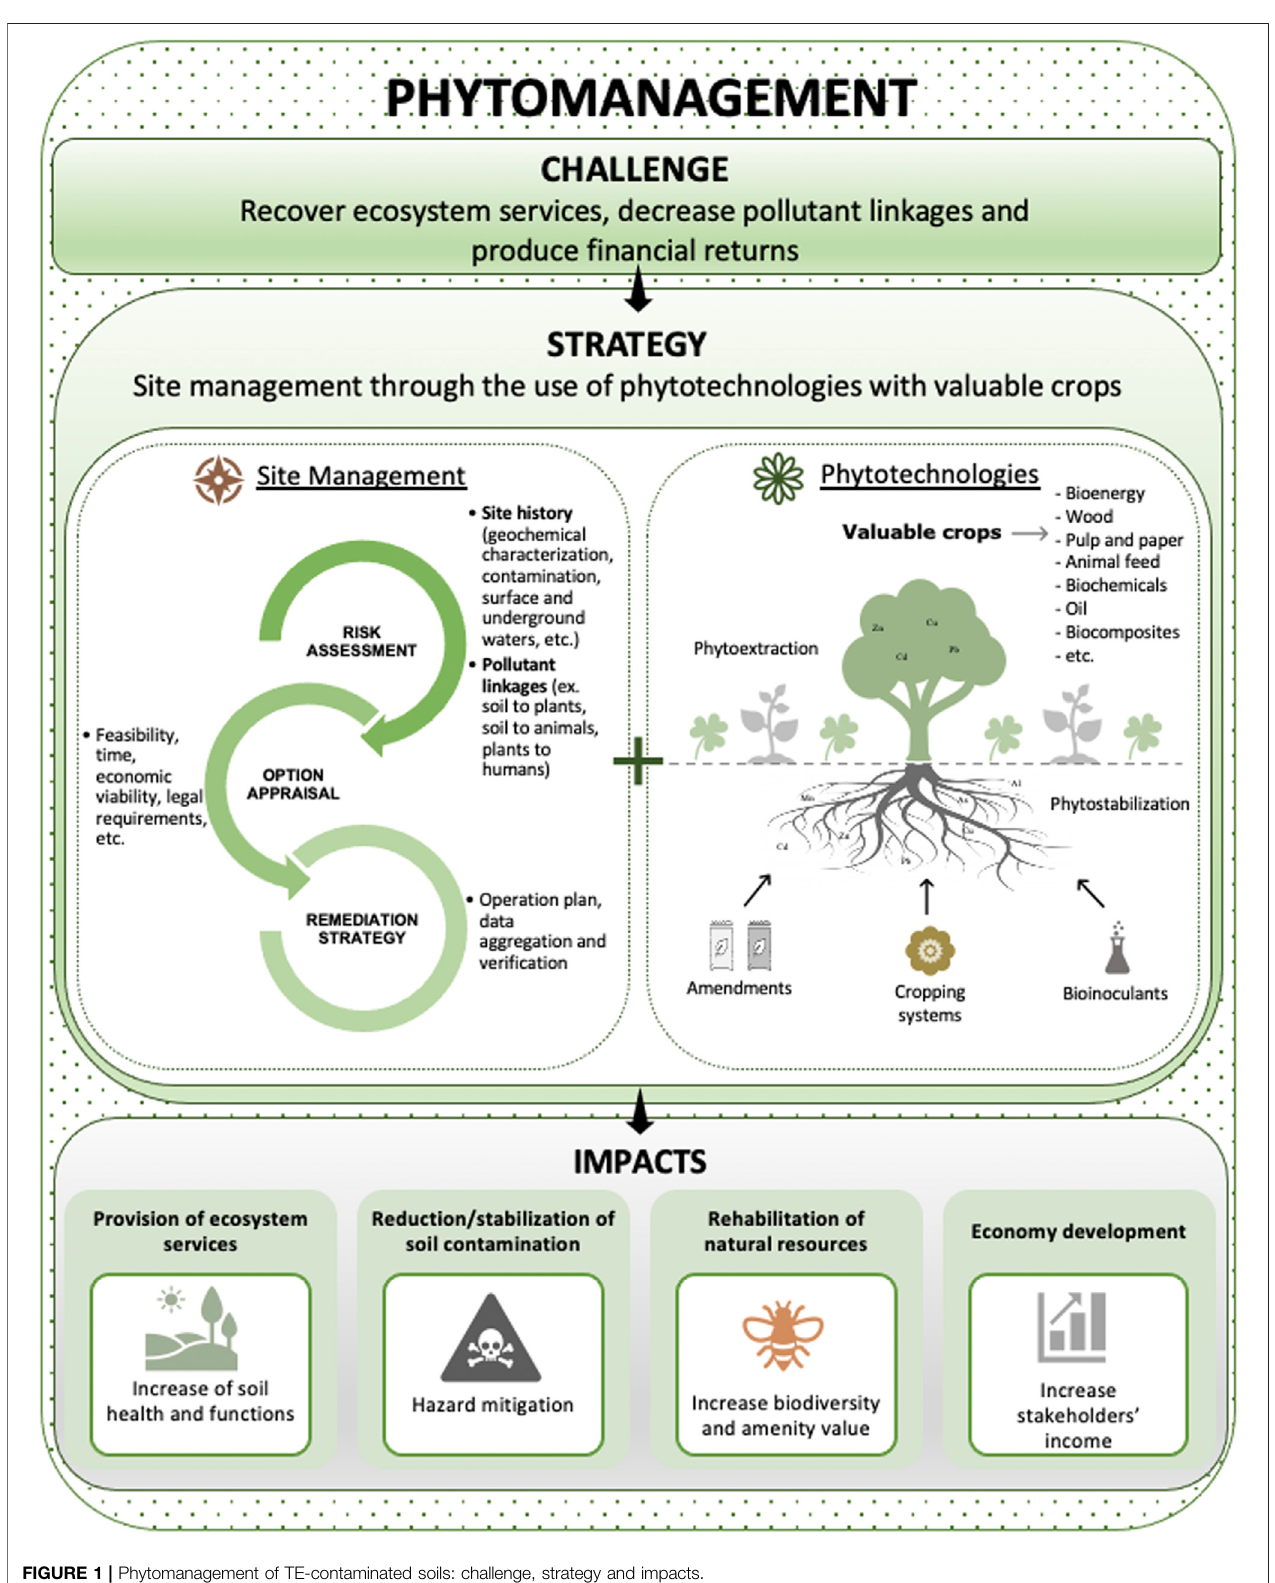
FIGURE 1 | Phytomanagement of TE-contaminated soils: challenge, strategy and impacts.